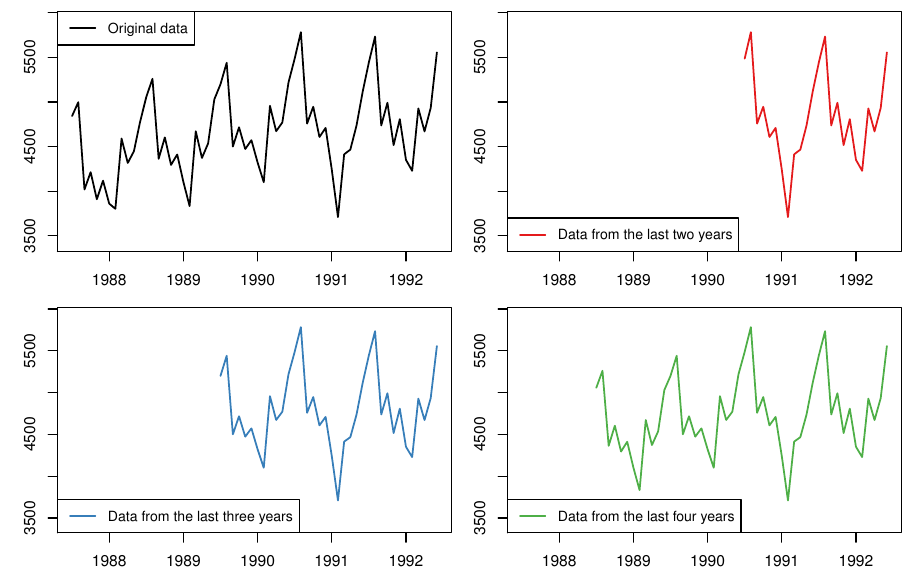
Figure 5. An illustrative example of producing series from multiple starting points. The original data (first panel) are trimmed so that the periods from only the last two years (second panel), the last three years (third panel), or the last four years (fourth panel) are